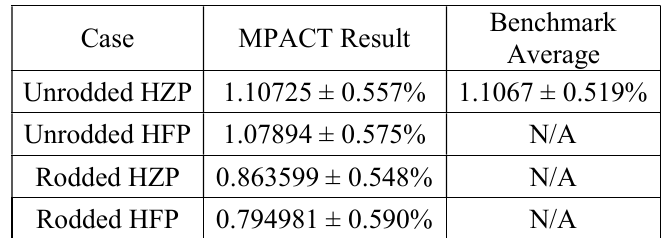
Table IV. BWR lattice results: Effective neutron multiplication factor and uncertainty calculated